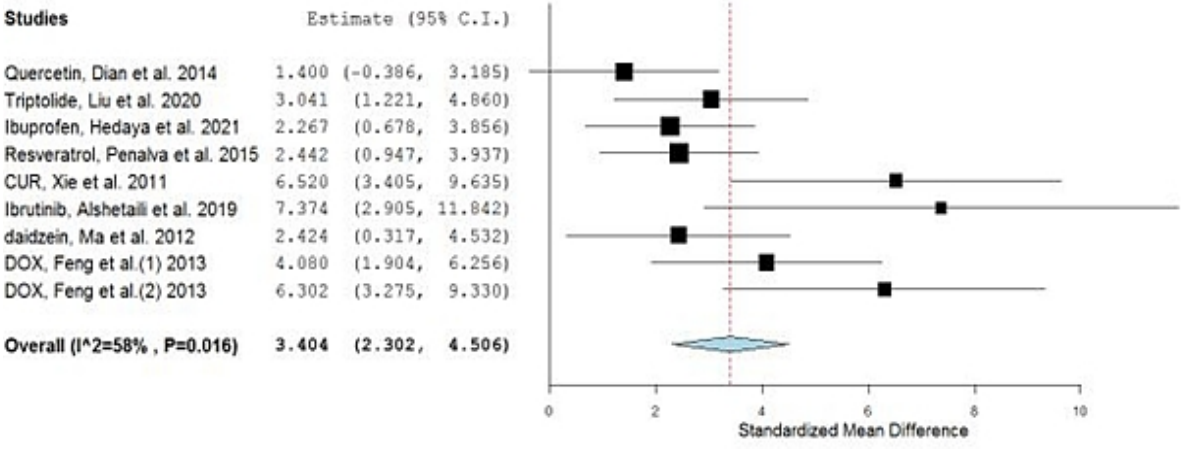
Figure 3. Forest plot of the optimized meta-analysis.